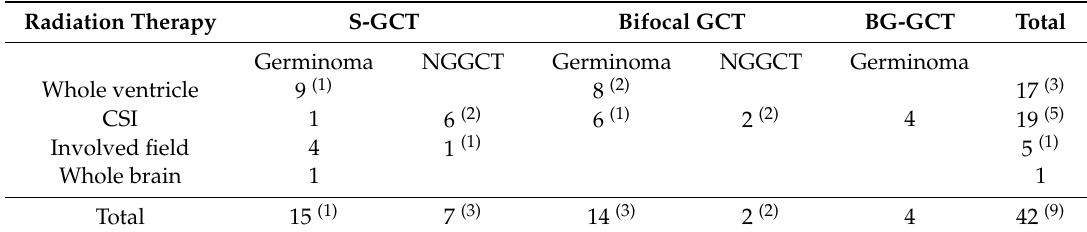
Table 5. Radiation therapy field and